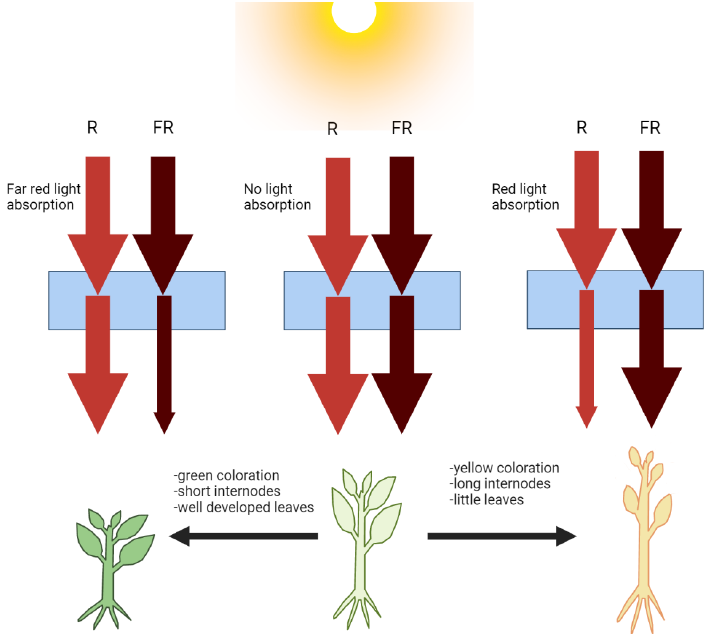
Figure 3. Effect of photoselective covers on changing the red light/far-red radiation ratio on plant development.